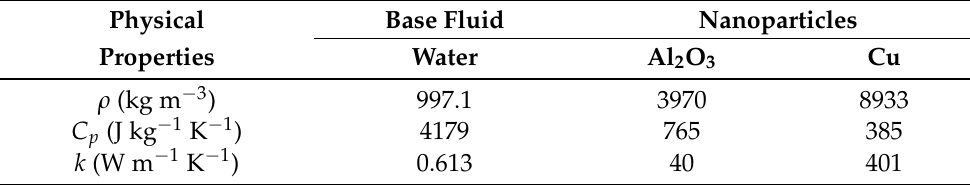
Table 1. Thermophysical properties of the water and nanoparticles. Physical Base Fluid